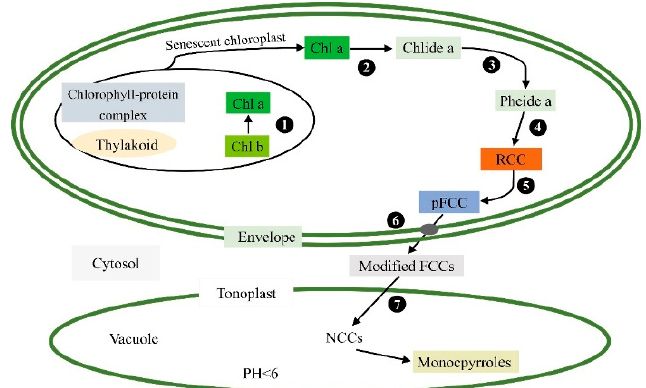
Figure 2. Biodegradation pathway of chlorophyll in higher plant. (1) Chl b reductase; (2) Chlorophyllase; (3) Metal chelating substance; (4) Pheide a oxygenase; (5) RCC reductase; (6) Catabolite transporter; (7) ABC transporter. Chl a, Chlorophyll a; Chl b, Chlorophyll b; Chlide a, chlorophyllide a; Pheide a, Pheophorbide a; RCC, red Chl catabolite; pFCC, primer fluorescent Chl catabolite; FCCs, fluorescent Chl catabolites; NCCs, nonfluorescent Chl catabolites.